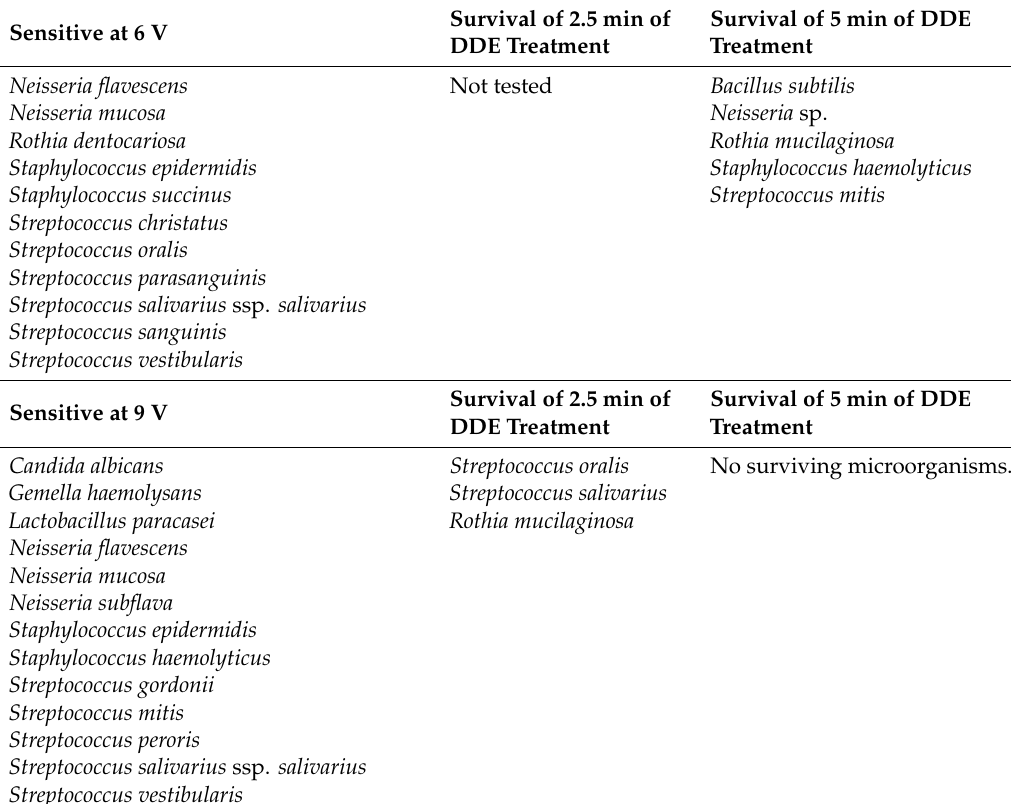
Table 3. Bacteria identified using MALDI-ToF and listed according their maximum resistance against DDE